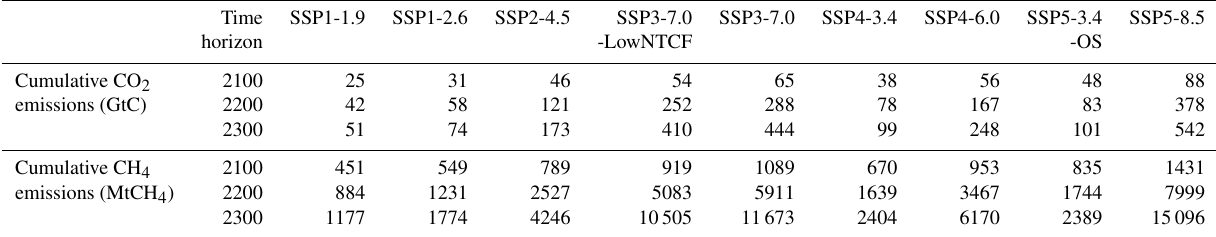
Table 2. Cumulative CO 2 and CH 4 emissions from MAGICC’s permafrost module under the considered SSPs. The permafrost module has 50 zonal bands, a mineral and peatland soil module, and 50 latitudinal zonal bands. See Schneider von Deimling et al. (2012) for a detailed description. See Fig. 3 for time series of induced CO 2 and CH 4 atmospheric concentration